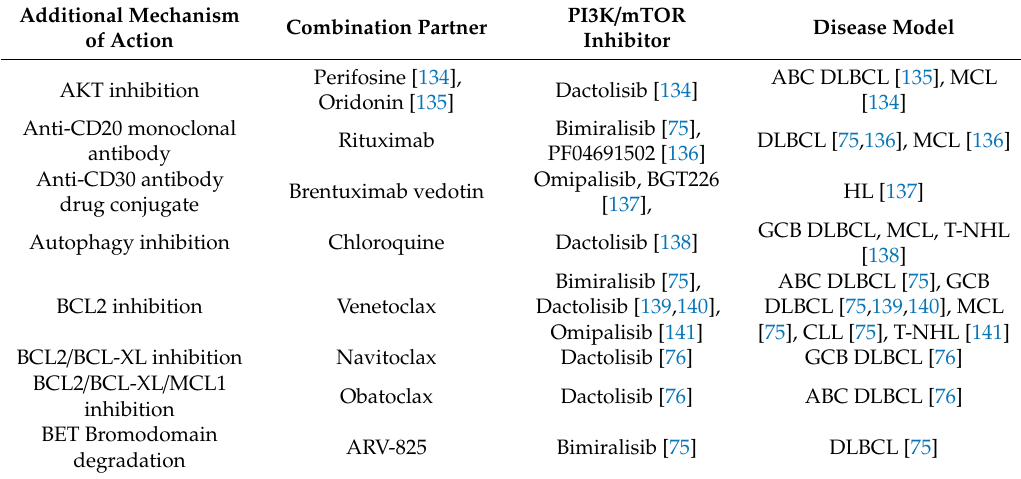
Table 4. Combinations based on dual PI3K / mTOR inhibitors with available preclinical data in